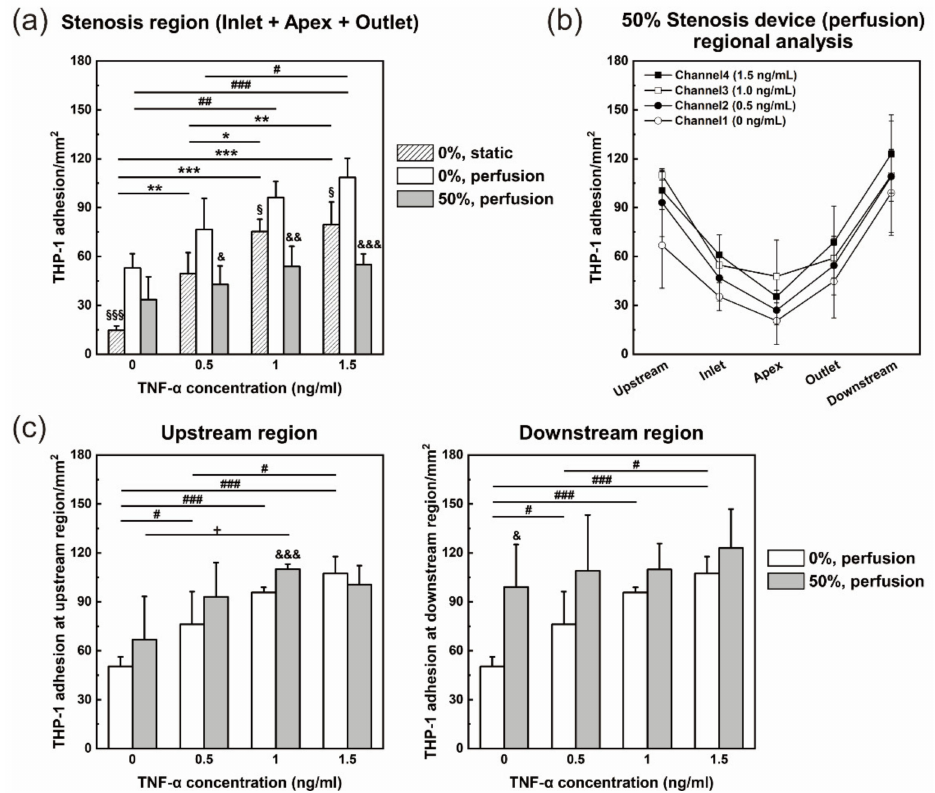
Figure 8. TNF- α dose-dependent monocytic THP-1 cell adhesion in the inflammation model. ( a ) THP-1 adhesion in the stenosis region of each channel of each conditioned device. * p < 0.05, ** p < 0.01, *** p < 0.001; # p < 0.05, ## p < 0.01, ### p < 0.001; § p < 0.05, § § § p < 0.001 and & p < 0.05, && p < 0.01, &&& p < 0.001 vs. 0% stenosis device in the perfusion condition. ( b ) Regional analysis of each stenosis channel in a 50% stenosis device in the perfusion condition. ( c ) Upstream region and downstream region analyses between a nonstenotic and a 50% stenosis device in the perfusion condition. For the upstream graph, # p < 0.05, ### p < 0.001; + p < 0.05; &&& p < 0.05. For downstream graph, # p < 0.05, ### p < 0.001; & p < 0.05. All n = 4 independent